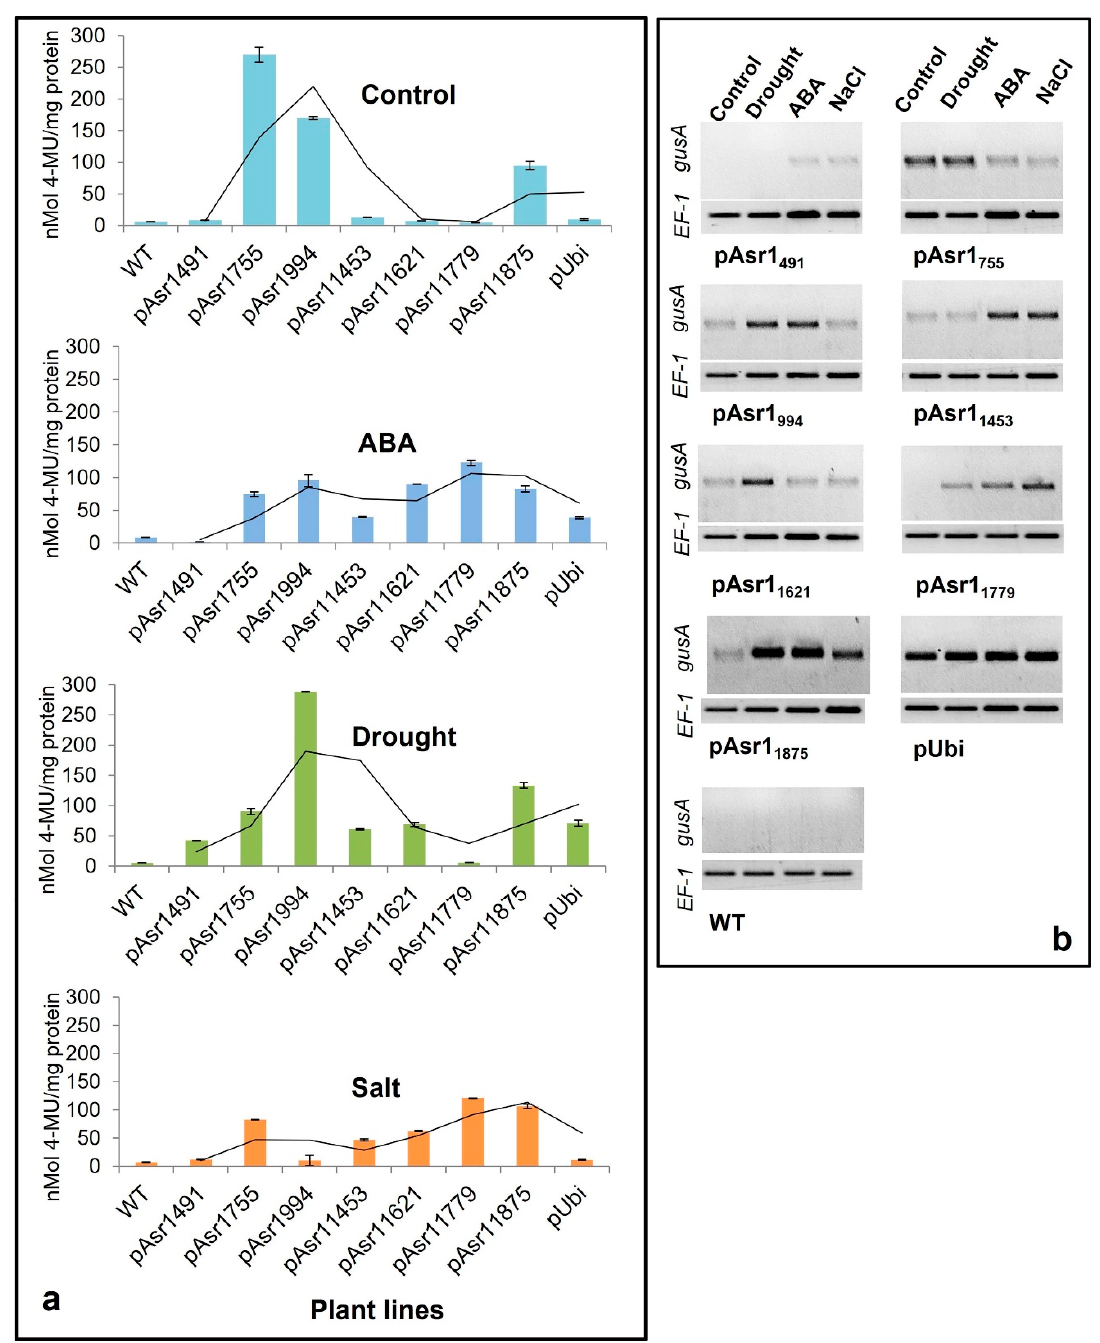
Figure 3. Quantitative MUG assay to measure GUS activity expressed as MU released/mg of total protein ( a ) and RT-PCR showing gusA transcripts ( b ) of Arabidopsis transgenics expressing the reporter gene driven by pASR1 promoter constructs and constitutive maize ubiquitin promoter under unstressed control and after a week of exposure to multiple abiotic stresses. The lines across data points in Figure 3a represent 2-period moving average trendlines.